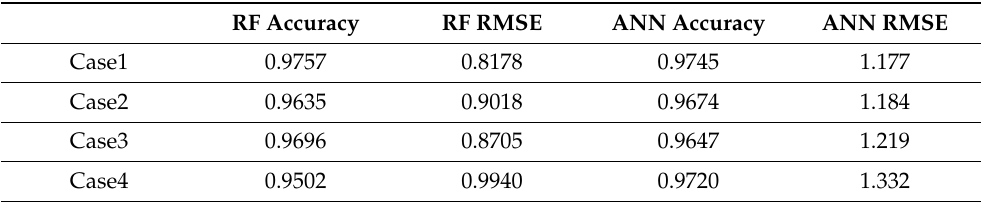
Table 4. Results of the random forest and artificial neural network